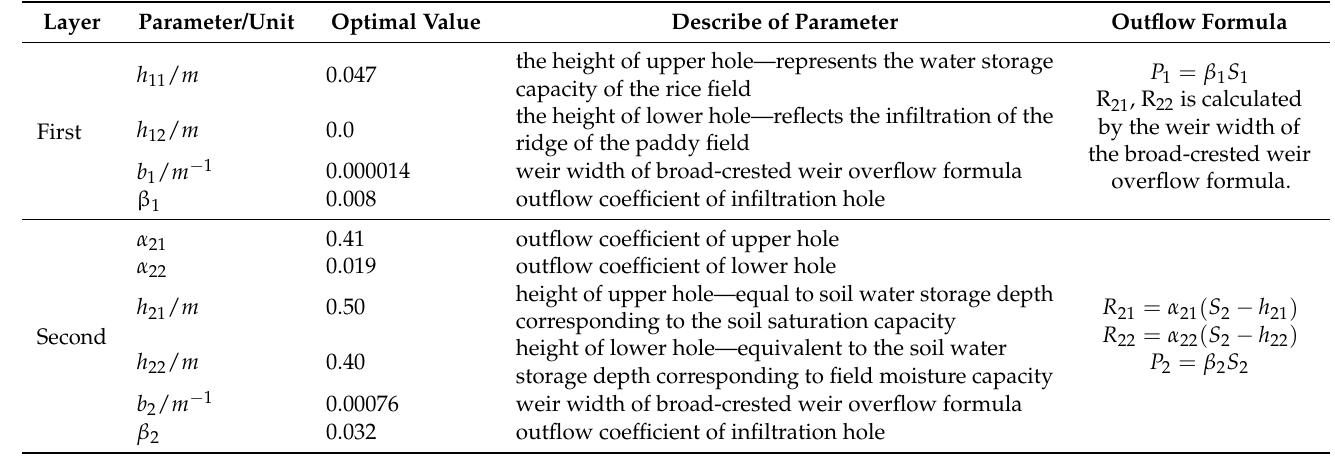
Table 2. Calibrated parameters of the two-layer tank